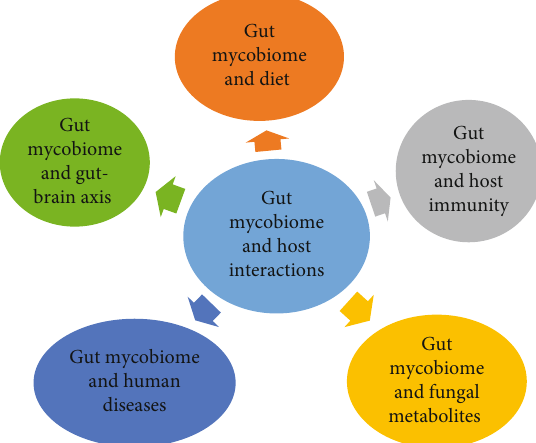
Figure 1: The interactions between gut mycobiome and host in various